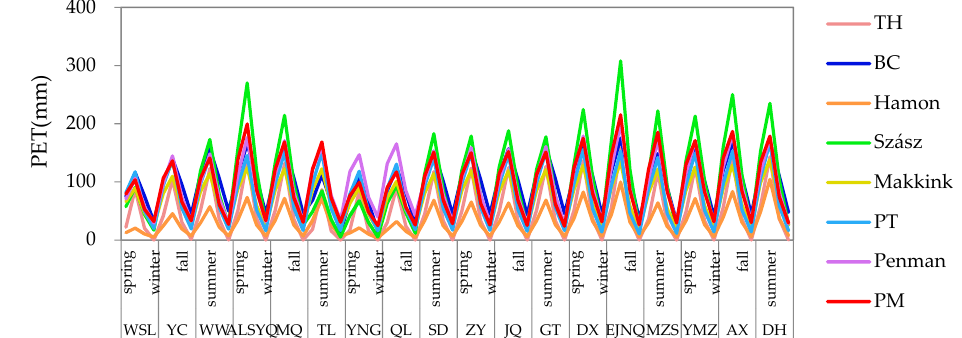
Figure 6. Intra-annual distribution of PET values from eight models.